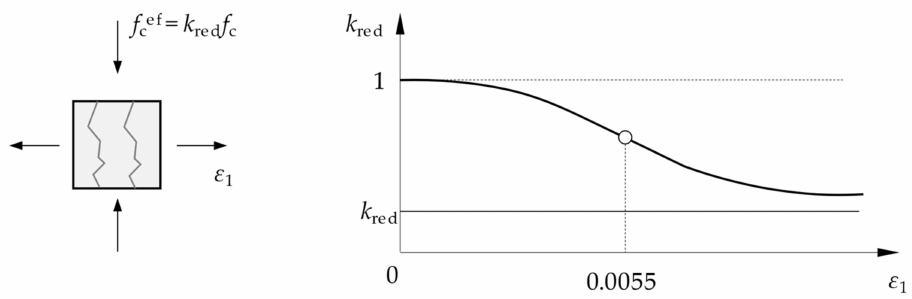
Figure 10. Compressive strength reduction of cracked